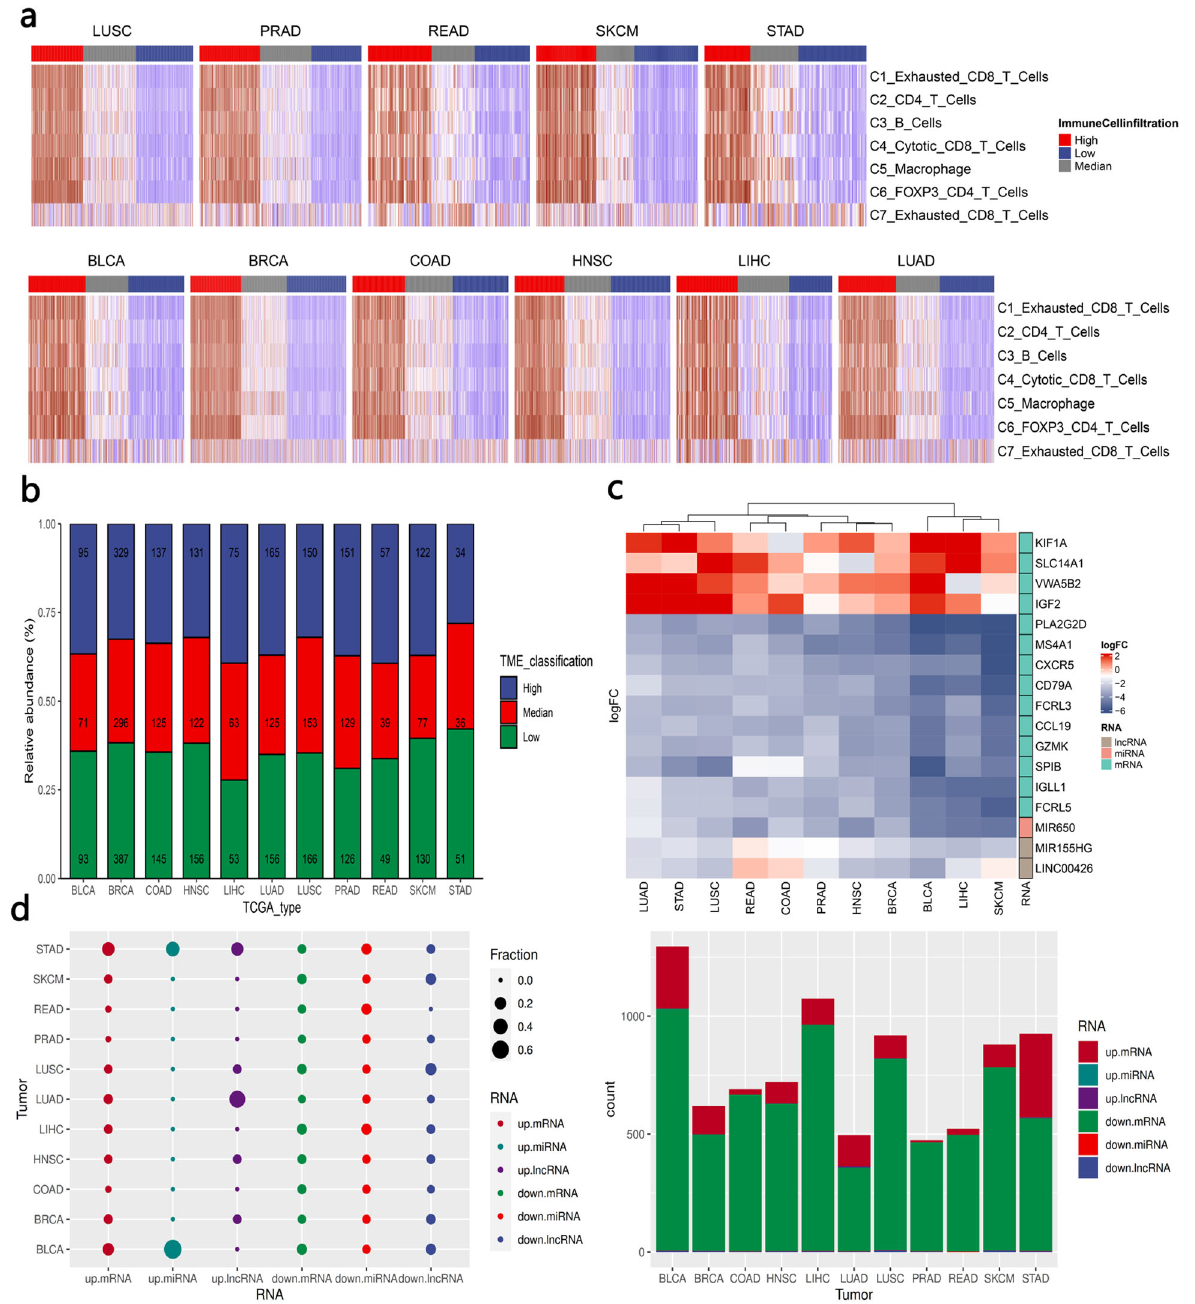
Fig. 2 Unsupervised clustering identi fi cation of the cold/hot tumor immune microenvironment. a Heatmap for global expression (estimated with the GSVA algorithm) of immune cell markers in each TCGA tumor type. b Stacked bar plot for the proportion of immune microenvironment type in each tumor type. The number in each bar is the number of tumor samples assigned to the corresponding TME classi fi cation (high: in fl amed, low: nonin fl amed, median: excluded). c Heatmap for the differentially expressed molecular characteristics (including mRNA, lncRNA, miRNA). The heatmap cell is colored according to the fold change of genes in differential expression analysis, where red represents genes that are upregulated in nonin fl amed tumors. d Overview of the molecular signature differences between in fl amed and nonin fl amed TMEs. The fraction in the left panel represents the proportion of molecular characteristics from a tumor type among the molecular characteristics from all tumor